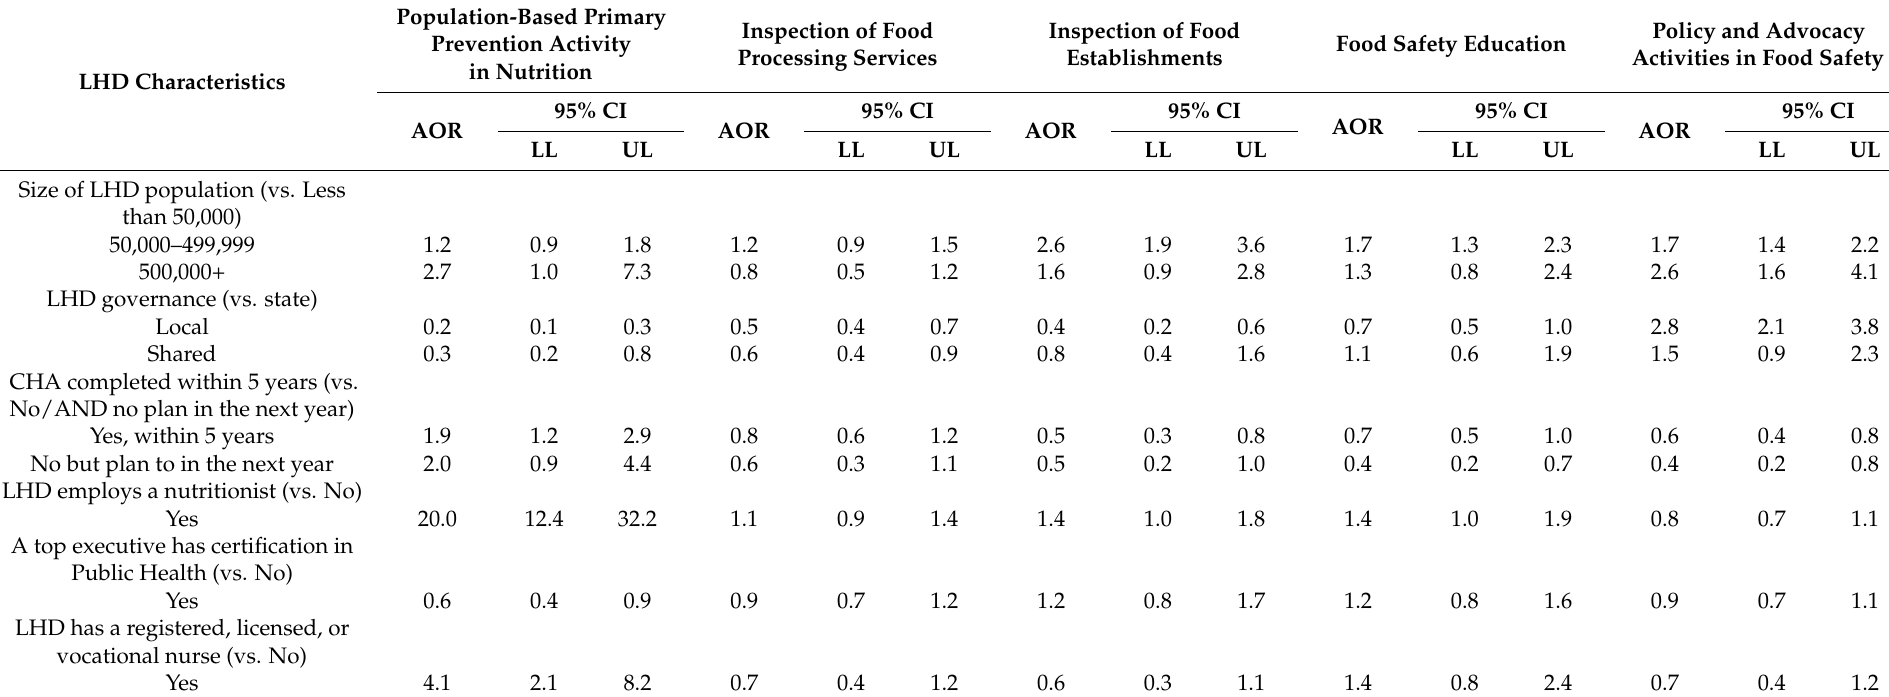
Table 2. Logistic regression of food LHD activities for food safety inspections, education, primary prevention, and policy,